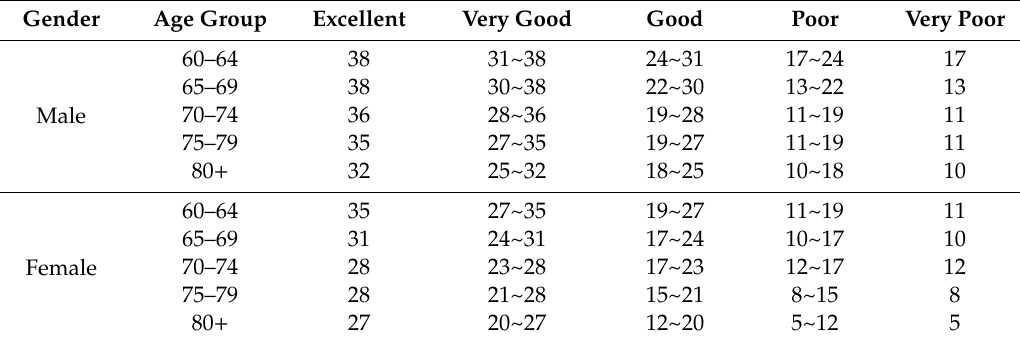
Table 18. One-minute sit-to-stand 5-grade relative evaluation norms, Unit: reps.